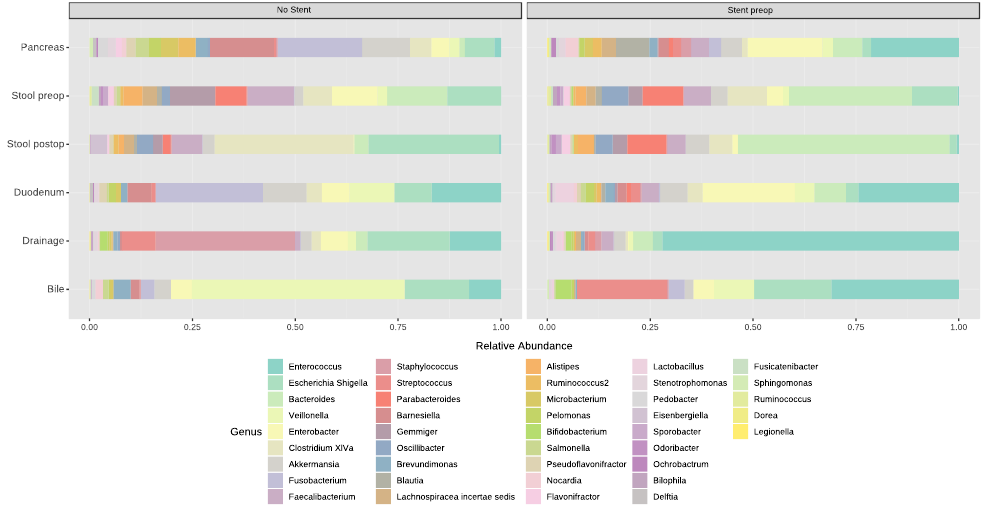
Figure 5. Bar plots representing the microbiome comparison on the genus level of patients without stent placement (no stent) vs. patients with stent placement pre-operative (stent